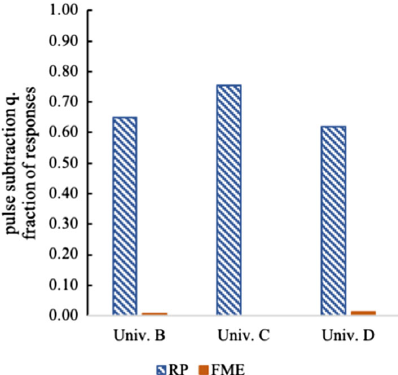
FIG. 16. Fraction of responses assigned the RP or FME codes for the explain-style question on superposition (the why super- position question ).